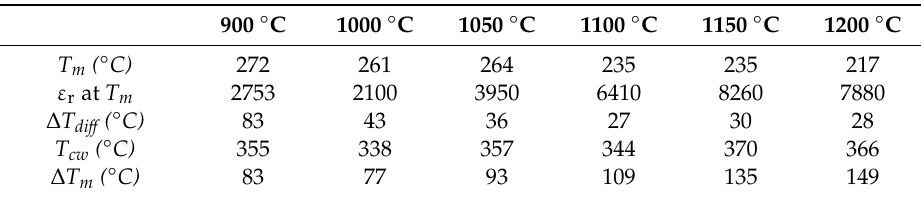
Figure 2. ( a ) Dielectric constant and loss vs. temperature curves for PLZT 8 / 60 / 40 ceramics sintered at di ff erent temperatures. ( b ) Change in T m and the value of dielectric maxima as a function of microwave sintering temperature. The parameters are measured at 1 kHz. Table 2. Temperature-dependent dielectric properties of microwave sintered PLZT 8 / 60 / 40 ceramics measured and calculated at 1